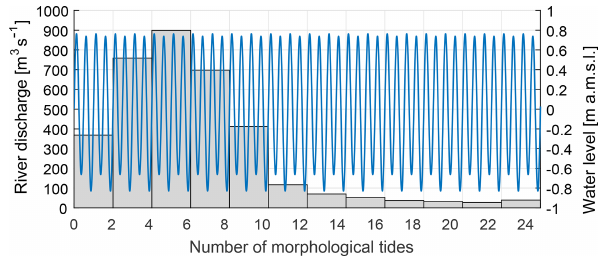
Figure 3. Schematization of the sea and river boundary conditions for 1year of morphological